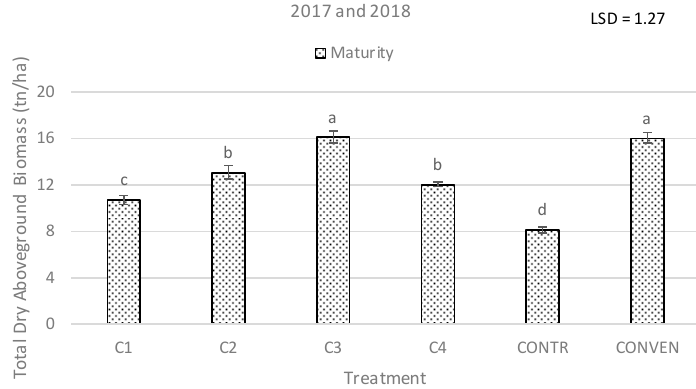
Figure 5. Total dry aboveground biomass of rice plants (means ± se) grown in di ff erently fertilized soil